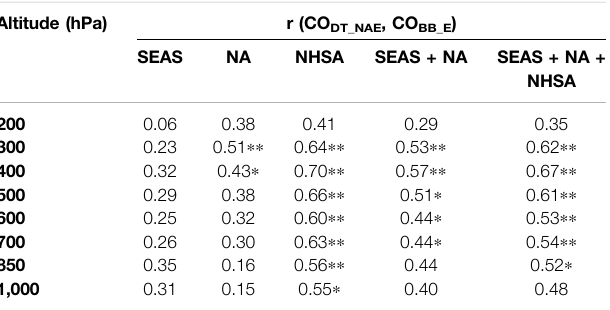
TABLE3| Correlationcoef fi cient( r )ofdetrendedCOconcentrationsovertheNAE (CO DT_NAE ) against fi re-induced CO emissions (CO BB_E ) from North America (NA), NH South America (NHSA), and Southeast Asia (SEAS). See Figure 4A for the region de fi